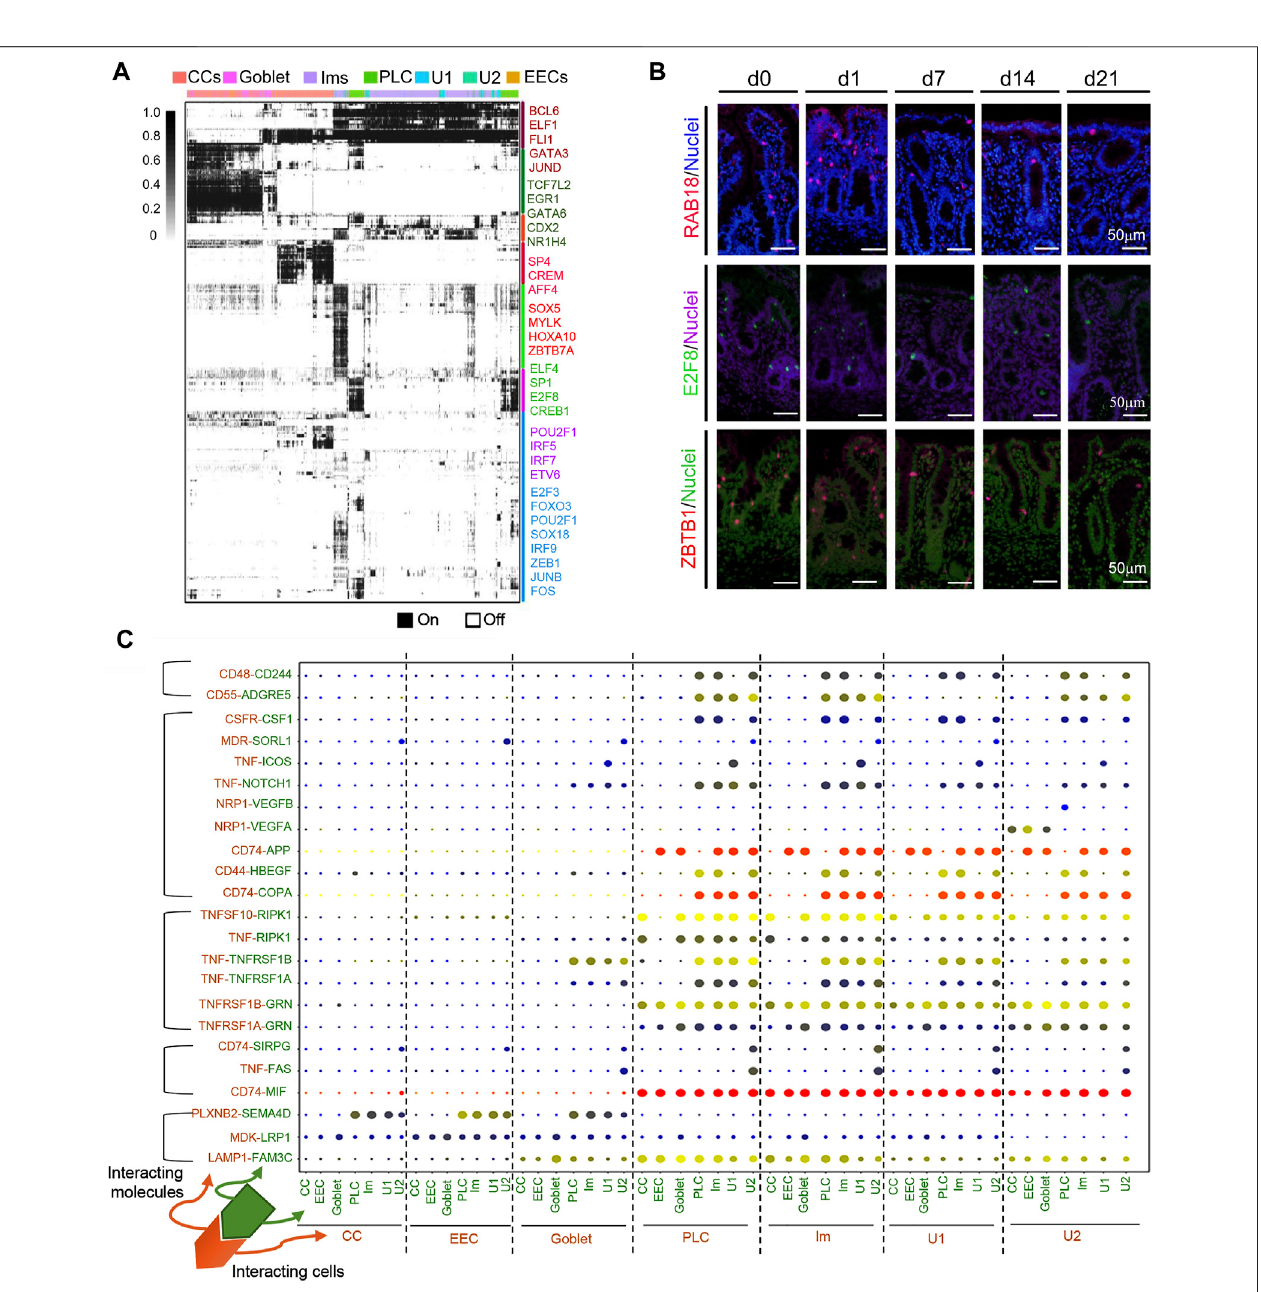
FIGURE 8 | Multiple regulatory networks in cecal cells in the neonatal window. (A) SCENIC binary regulon activity heatmap depicting different clusters of cecal epithelium cell enriched regulons. Columns contain single cells while the rows indicate regulons. “ On ” = active; “ Off ” = inactive. (B) IHF images of TFs between d0 and d21. Scale bar: 50 μ m. (C) Overview of selected ligand-receptor interactions; p -values are indicated by circle size; the scale is on the right (for permutation test, see Methods). Means of average expression levels of interacting molecule 1 (cluster 1) and interacting molecule 2 (cluster 2) are indicated by color. Assays were performed at the mRNA level, but here they are extrapolated to protein interactions.